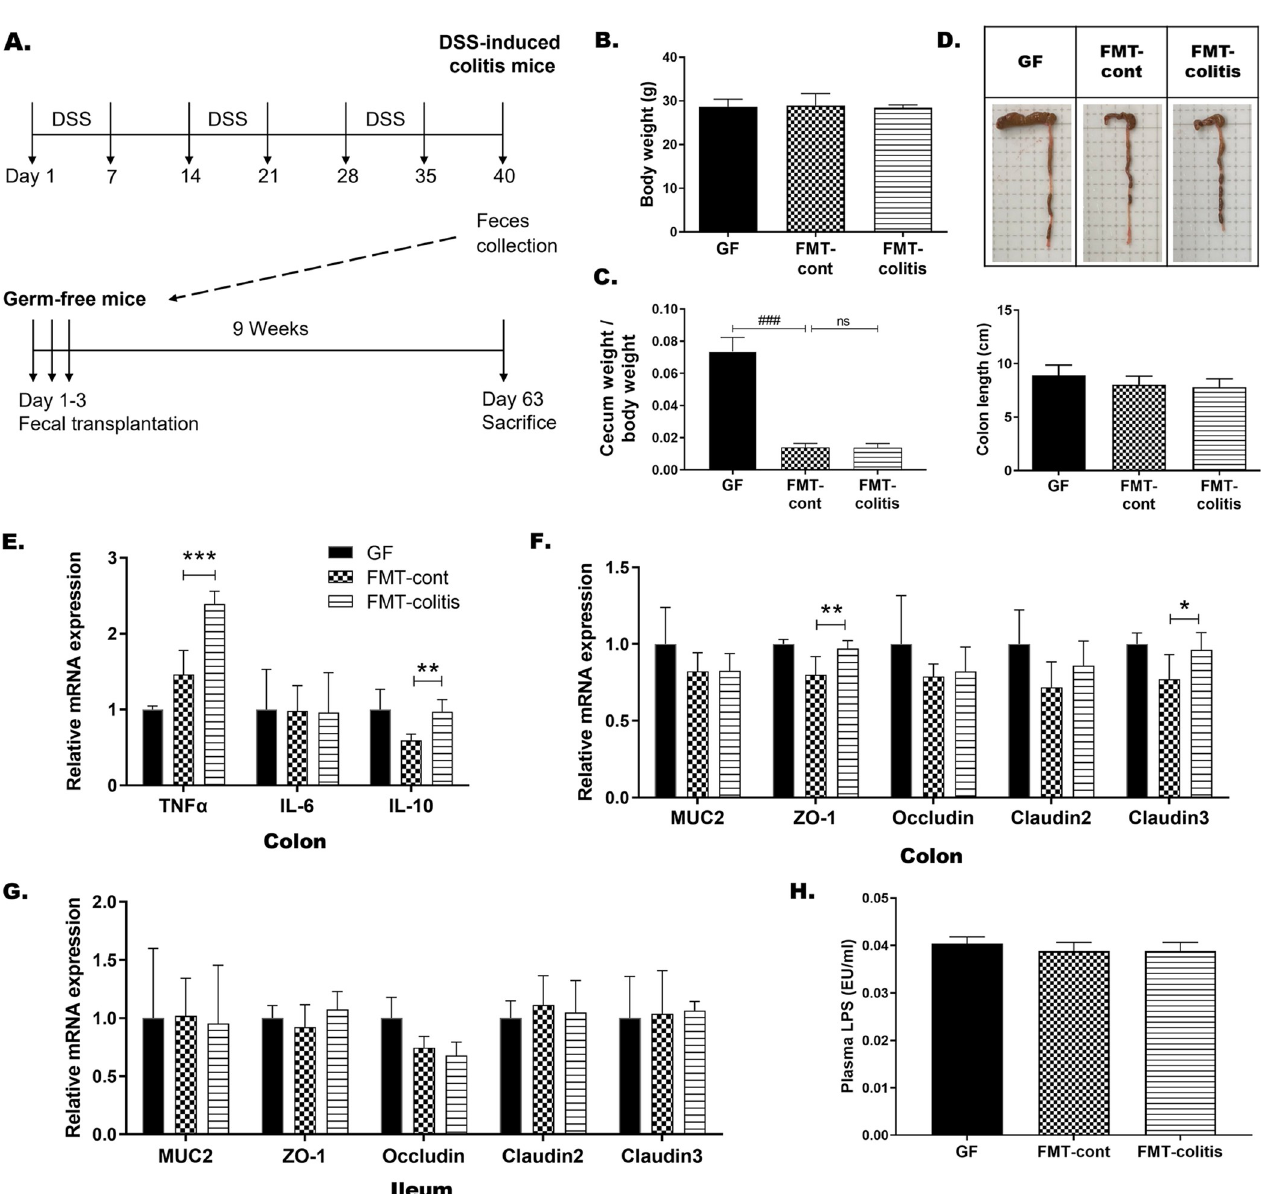
Fig 1. Transplantation of fecal microbiota from DSS-induced colitis mice did not drive inflammation or barrier disruption in the gut of GF recipient mice. (A) Experimental schedule. (B) Body weights and (C) cecum-to-body weight ratio at the time of sacrifice in each group of mice. (D) Representative photographs of colon and cecum from each group and a graph presenting the colon length. In B-D, statistical significance was determined by ordinary one-way ANOVA with Dunnett’s multiple comparison test ( # p < 0.033, ## p < 0.002, and ### p < 0.001). The mRNA expression of (E) TNF α , IL-6, and IL-10 in colon, and (F and G) mucin and tight junction related genes in colon and ileum. (H) Plasma LPS levels measured by ELISA. Data are presented as the mean ± SD of each group (n = 5–7). In E-H, statistically significant difference between FMT-control and FMT-colitis group was determined by Student’s two-tailed t-test ( � p < 0.05, �� p < 0.01, and ��� p < 0.001). GF: GF mice without fecal transplantation, FMT-cont: GF mice transplanted with fecal microbiota from non-colitis mice. FMT-colitis: GF mice transplanted with fecal microbiota from DSS-induced colitis